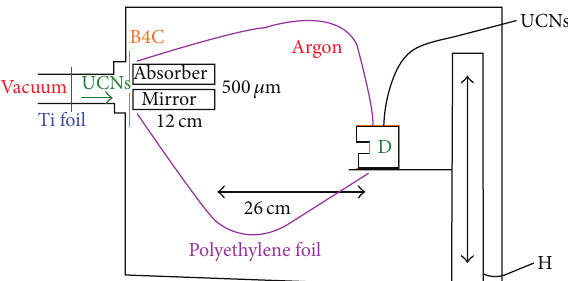
Figure 13: Set-up for free fall measurement: in an argon-filled box, the UCN beam is collimated with a 12cm long absorber-mirror system forming a slit of height 500 𝜇 m. A detector with a 15 𝜇 m thick titanium window is placed at the distance of 26 cm from the slit, and record the neutron count as a function of the fixed free fall